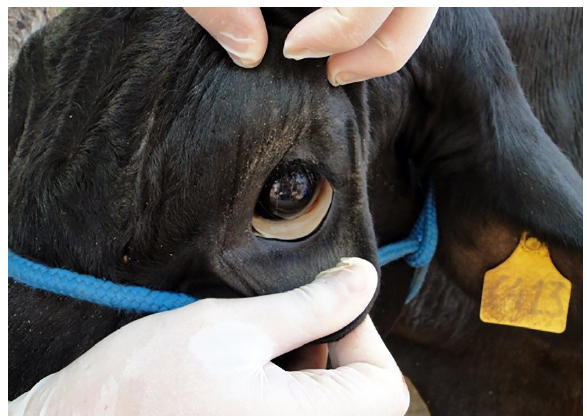
Figure 2. Severe enophthalmos and hypopigmented ocular